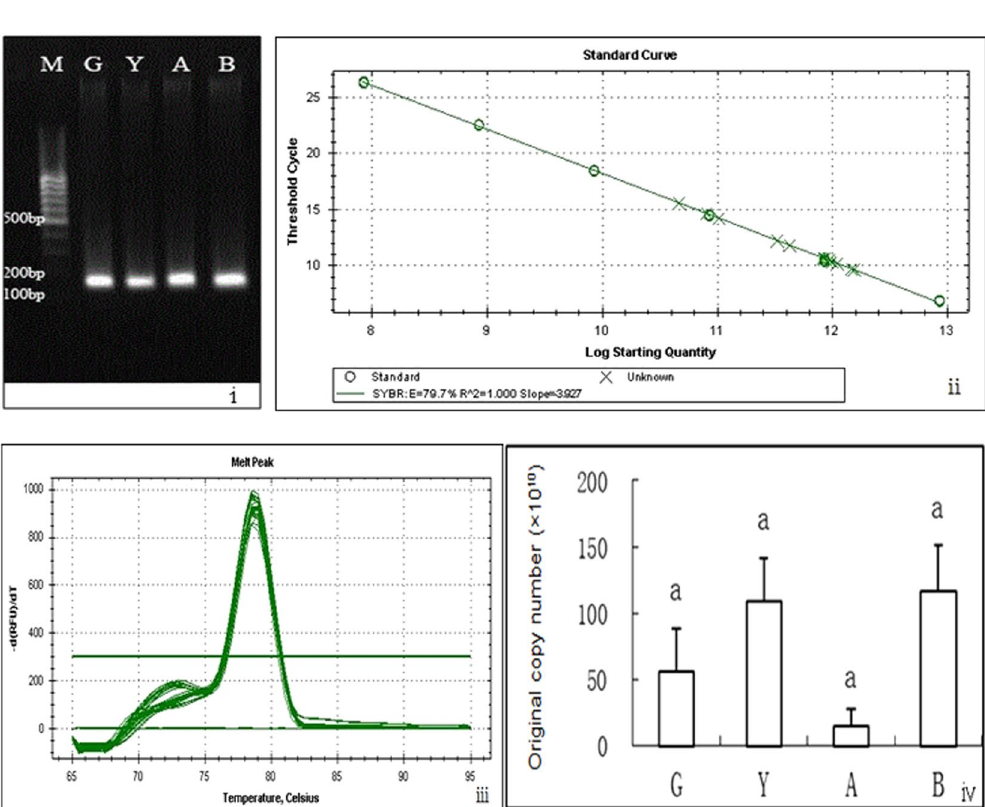
Figure 6. Expression assays of the tubulin gene among different phases of S. chinensis . (i) Gel electrophoresis of amplified product. (ii) Standard curve. (iii) Melt peak of tubulin gene. (iv) Quantitative assays of expression level: P > 0.01. M: Marker. G: fundatrigenia. Y: overwintering larvae reared at natural condition. A: overwintering larvae reared at constant temperature 18 °C. B: overwintering larvae reared at a constant temperature 7.5 °C. Same letter on the bar of the bar graph mean no significant